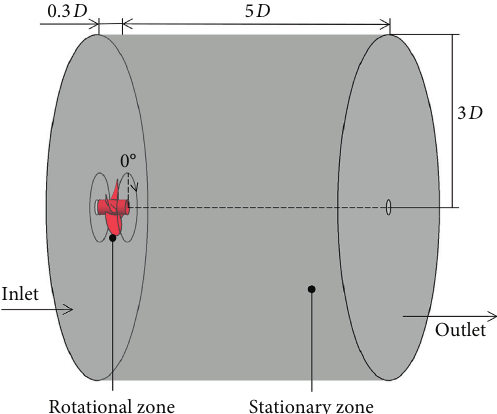
Figure 1: Computational